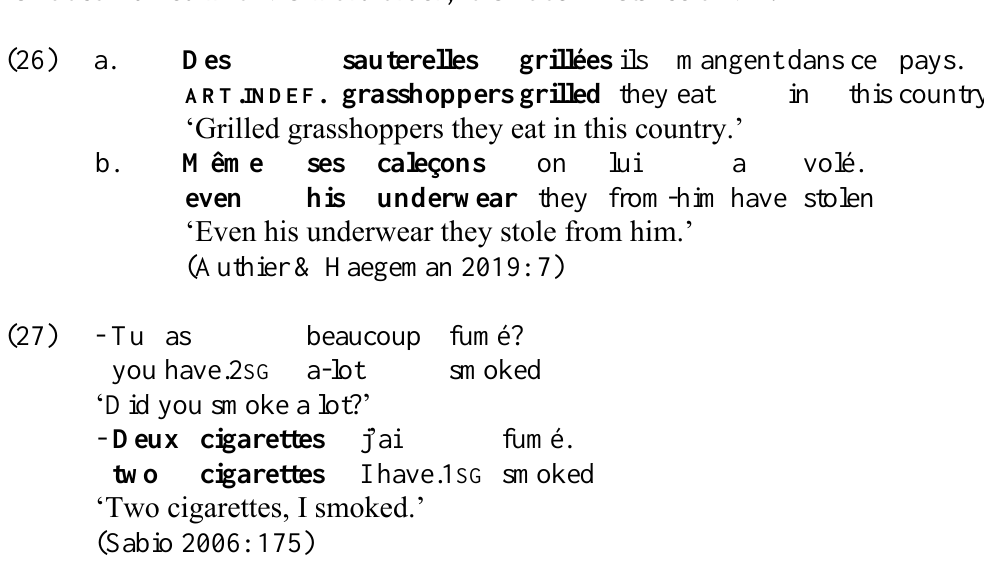
information exhaustive mirative corrective focus focus focus